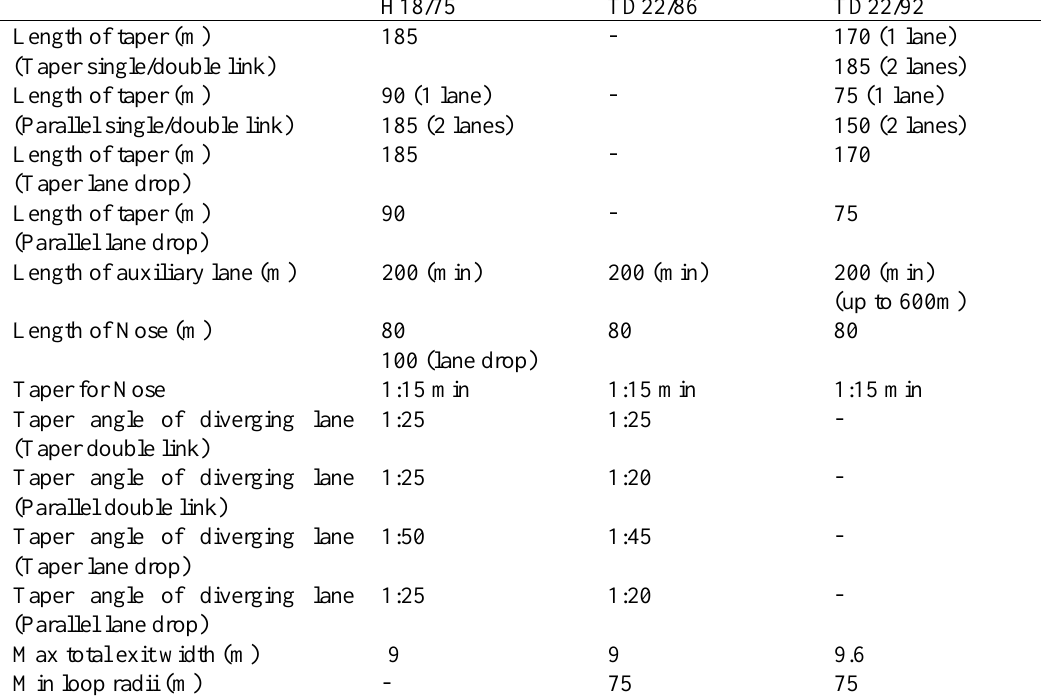
Table 2. Comparison of diverge layout parameters for three UK